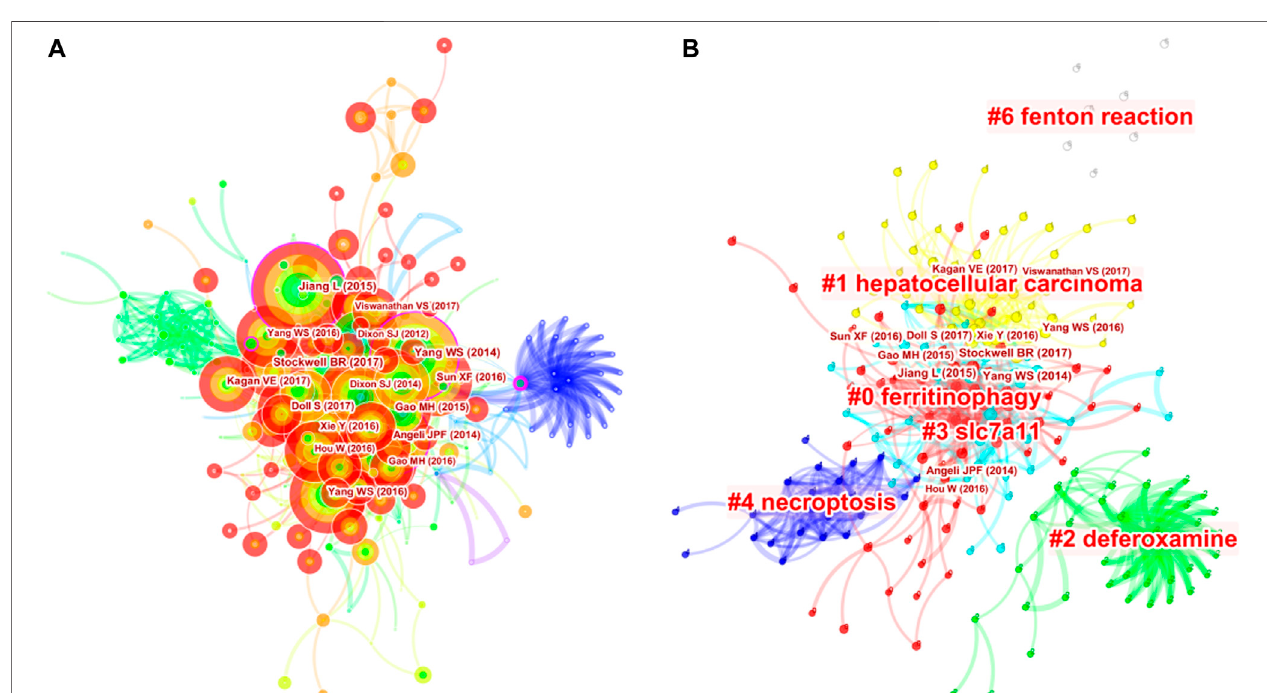
FIGURE 4 | Analysis of references to ferroptosis in cancer research. (A) Network map of co-cited references. (B) Network map of co-cited clusters.